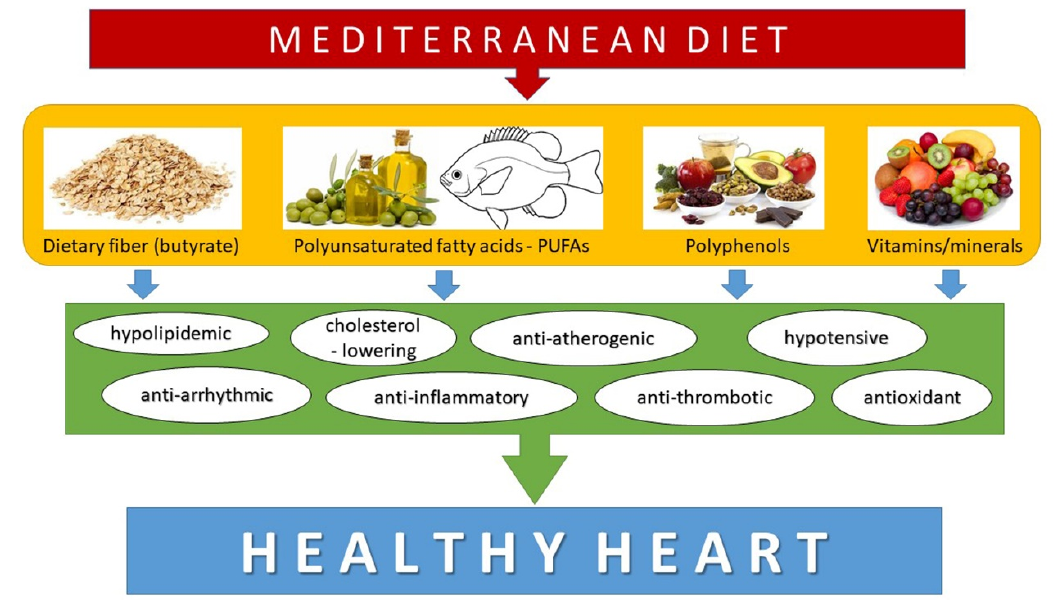
Figure 2. The main bioactive dietary components of the Mediterranean diet and their beneficial effects on the cardiovascular